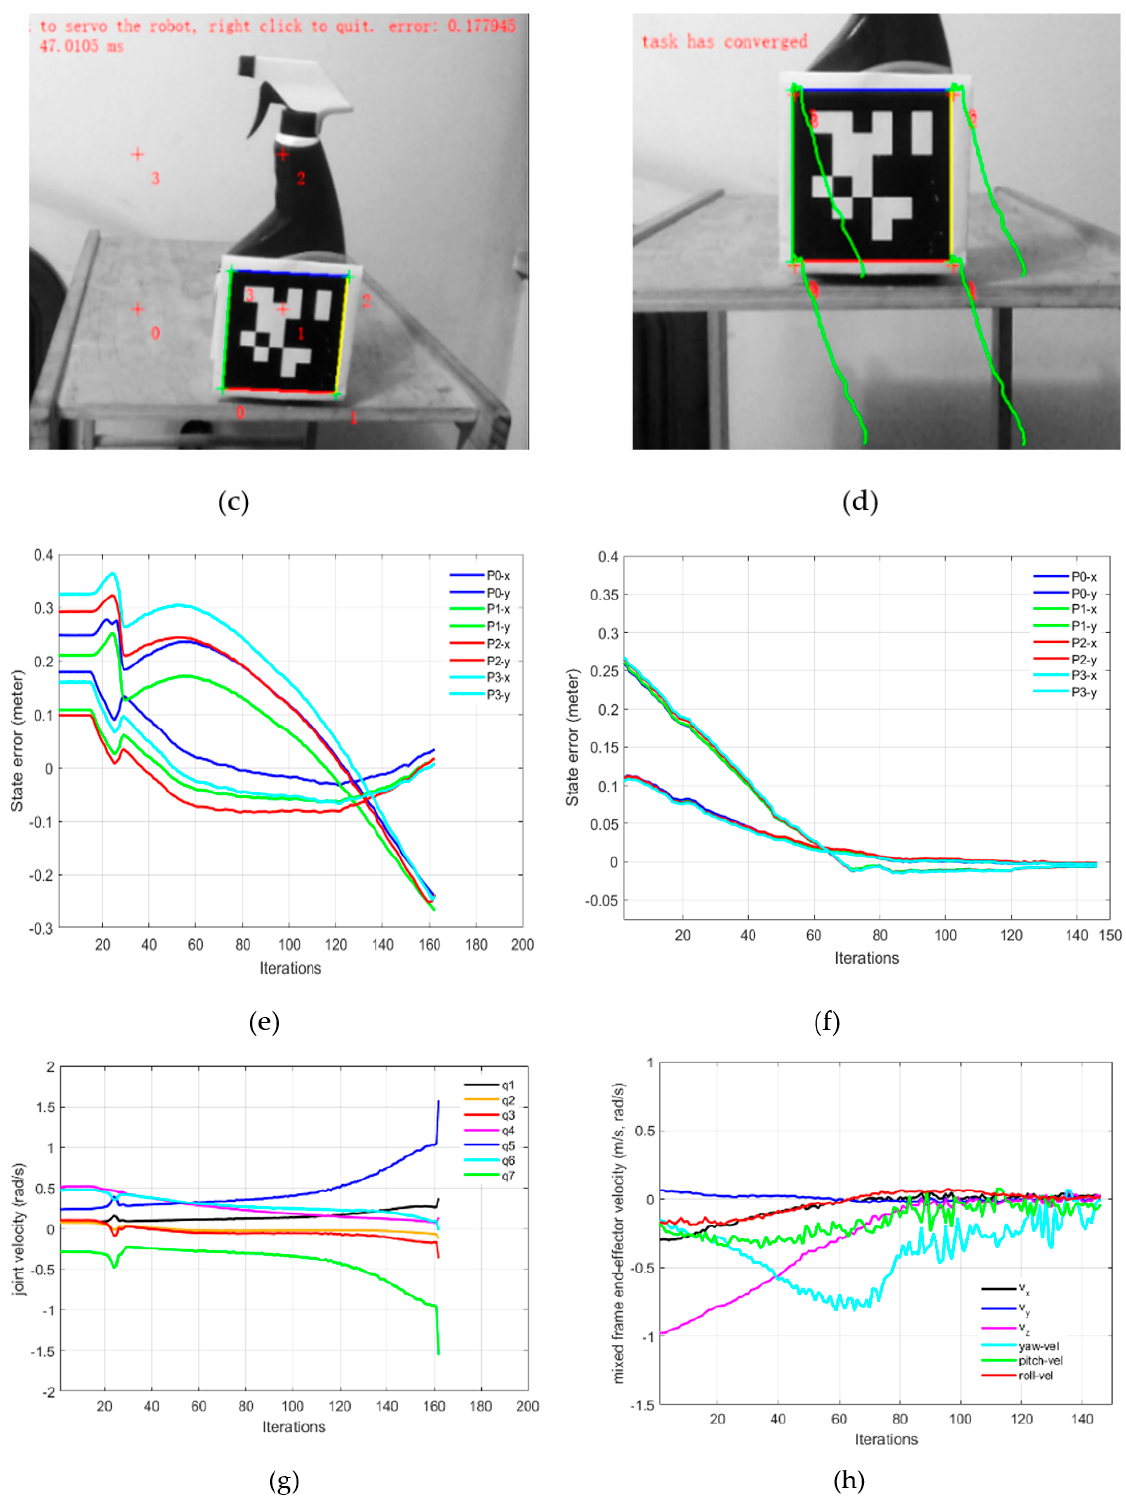
Figure 11. Mix frame visual servo control in extended arm position, ( a ) starting pose, ( b ) end pose, ( c ) initial and desired image features, ( d ) feature trajectory in the image plane for mix frame control, ( e ) feature error in joint control, ( f ) feature error in mix frame control ( g ) joint velocities of joint controlled visual servoing, ( h ) mixed frame end-effector velocity for the proposed control scheme.